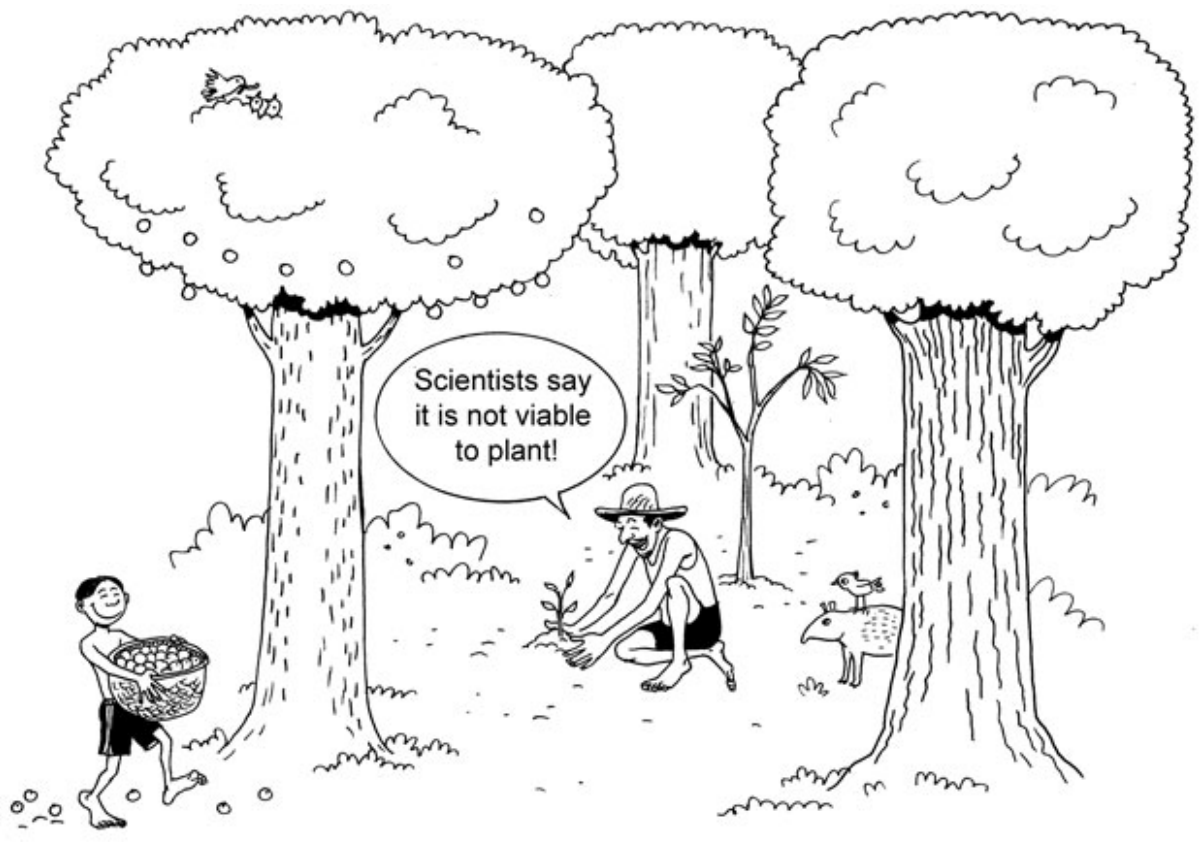
Fig. 14. Farmers successfully manage the fruit tree Endopleura uchi , whereas scientific literature states that it is not viable to plant. Source: Shanley and Medina